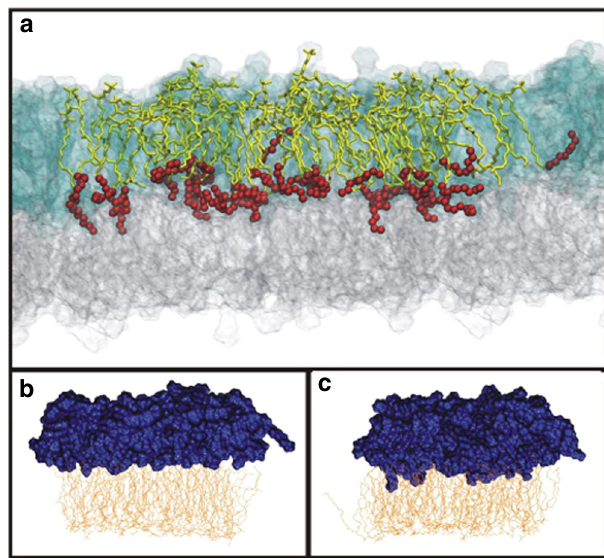
Fig. 2 Illustration of interdigitation between the two membrane lea fl ets. a Multicomponent bilayer where SM d18:1/24:0 molecules are shown as yellow sticks with the last eight carbon atoms depicted as red balls. Lipids in the outer lea fl et are shown as transparent blue glass, while lipids in the inner lea fl et are described as transparent grey glass. For clarity SM d18:1/ 24:0 molecules are marked only in the central part. b Model for a bilayer with PS 18:0/18:1 and cholesterol in the inner lea fl et and SM d18:1/16:0 and cholesterol in the outer lea fl et. c Similar to B, but SM d18:1/16:0 has been exchanged with SM d18:1/24:0. Blue colour is used for the outer lea fl et and yellow for the inner monolayer. Note that the N-amidated fatty acyl group med 24 carbon atoms (in C) are penetrating deeper into the opposite lea fl et than the species with 16 carbon atoms (in b ). For more details see ref. 52 , from where this fi gure is Gb3 is found both in detergent resistant membranes (DRMs) and non-DRM membrane fractions of many cell lines 44 .